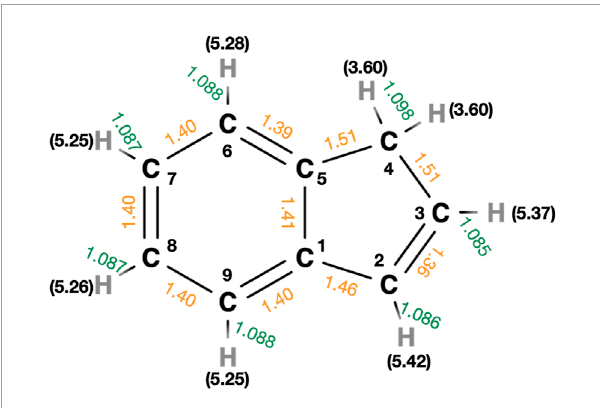
FIGURE 1 The geometry of indene optimized at MP2/6-311+G (d,p) level of theory. The bond lengths for C-H (in green) and C-C (in orange) bonds and hydrogen atom dissociation energies (in black), D 0 are presented. The units are Å and